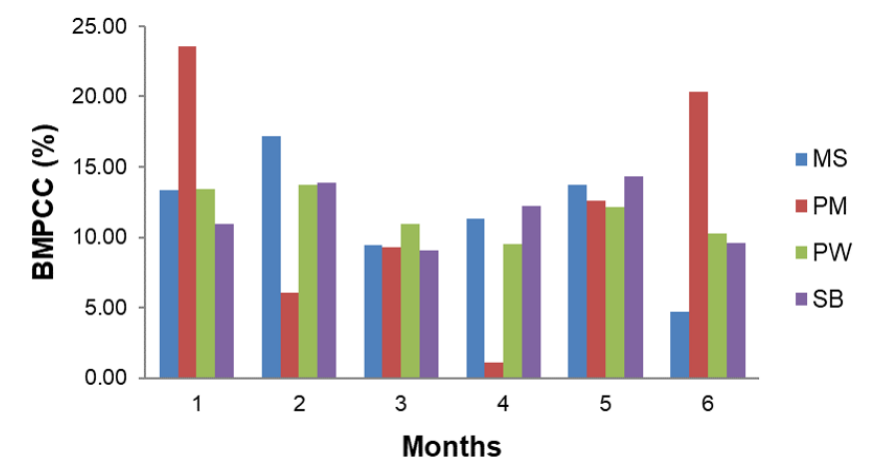
Figure 5. Values of the Biochemical Methane Potential Correction Coefficient for the substrates tested.